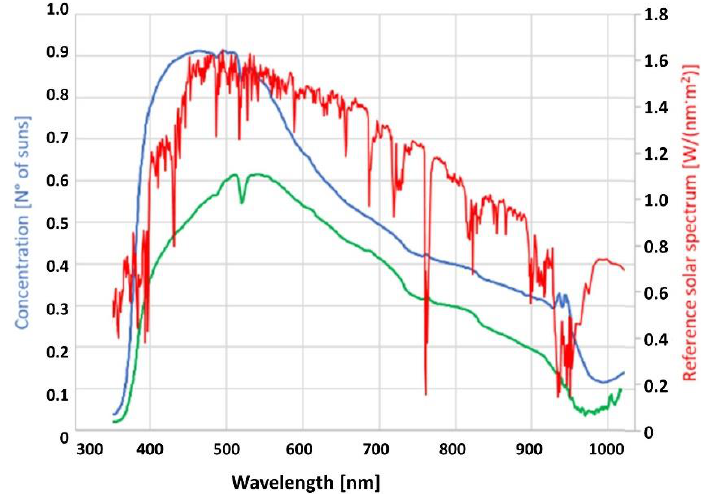
Figure 6. Solar concentration as a function of wavelength measured on the side of a window with the light spot at 8 cm (green) and at 3 cm distance from the side (blue). The solar spectrum is reported in red, for comparison.